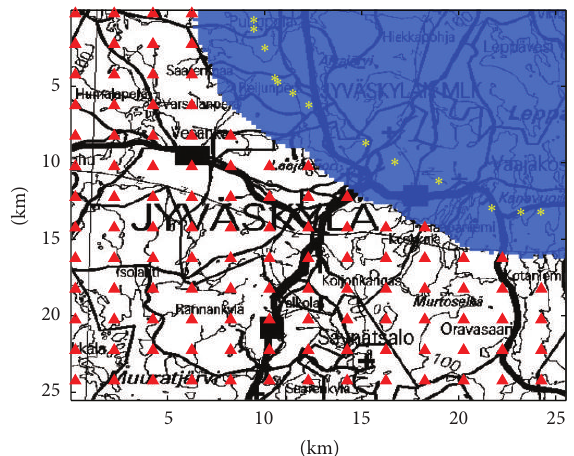
Figure 3: TV protection area (blue-shaded area), secondary BS (red triangles), and dominating TV test points (yellow stars).